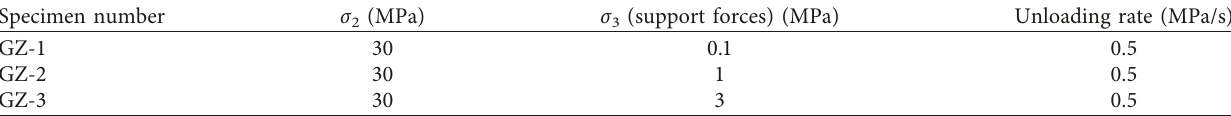
Table 1: Testing plan of one-single face true-triaxial unloading test under the true-triaxial condition with different support forces. Specimen number